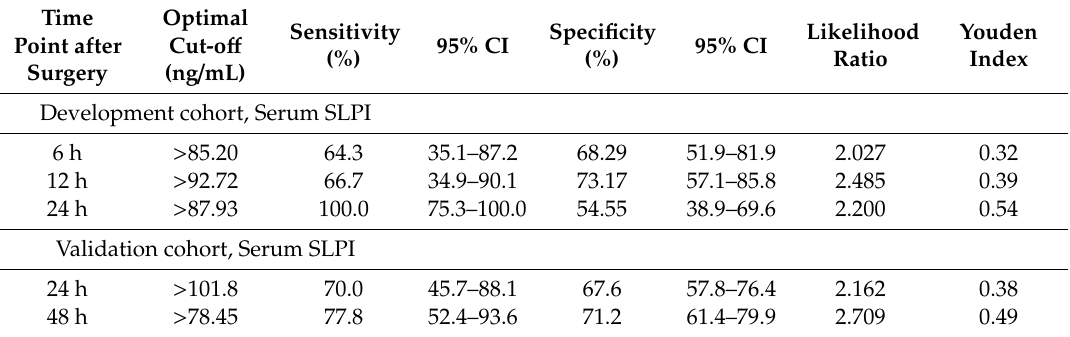
Table 4. Sensitivity and specificity of SLPI as a biomarker for AKI at optimal cut-o ff